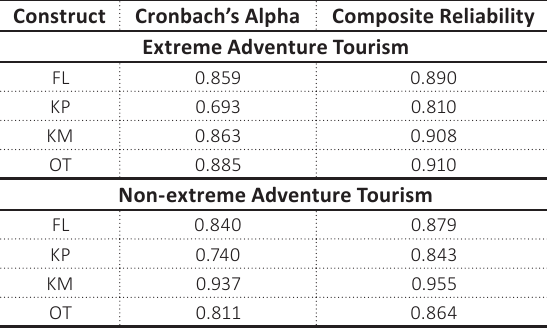
Table 5. Parameter value of extreme and non- extreme adventure tourism reliability